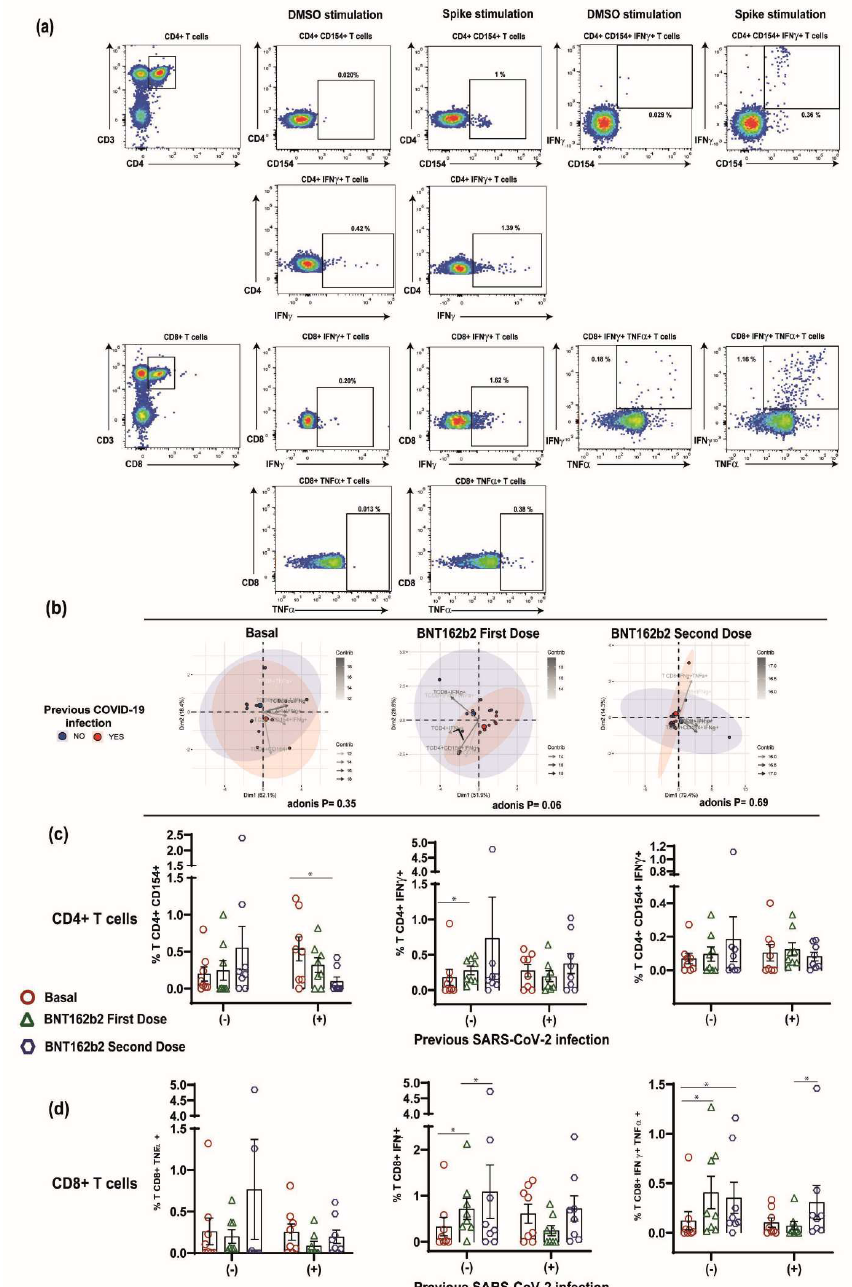
Figure 3. Stimulation of PBMC with a peptide pool of the SARS-CoV-2 spike protein. ( a ) Representa- tive example shows the gated CD4+ and CD8+ T-cell populations. Subsequently, we analyzed the CD4+ CD154+ T cells, CD4+ IFN- γ + T cells, and CD4+ CD154+ IFN- γ + T cells as well as CD8+ IFN- γ + T cells, CD8+ TNF- α + T cells, and CD8+ IFN- γ + TNF- α + T cells. Upon peptide pool stimulation, the results were compared to the negative control (DMSO). ( b ) PCA biplot showing PCA analysis of T-cell response compared over time: previous SARS-CoV-2 infection (red) vs. naïve participants (blue); arrows are drawn based on the percentage contribution of variables to each component. ( c , d ) Individual values of CD4+ and CD8+ T-cell populations reactive to SARS-CoV-2 are analyzed following timepoints: basal, 15 days after the first BTN162b2 dose, and 15 days after the second BTN162b2 dose. Differences between groups were determined by Mann–Whitney U test with an α =< 0.05; * p =